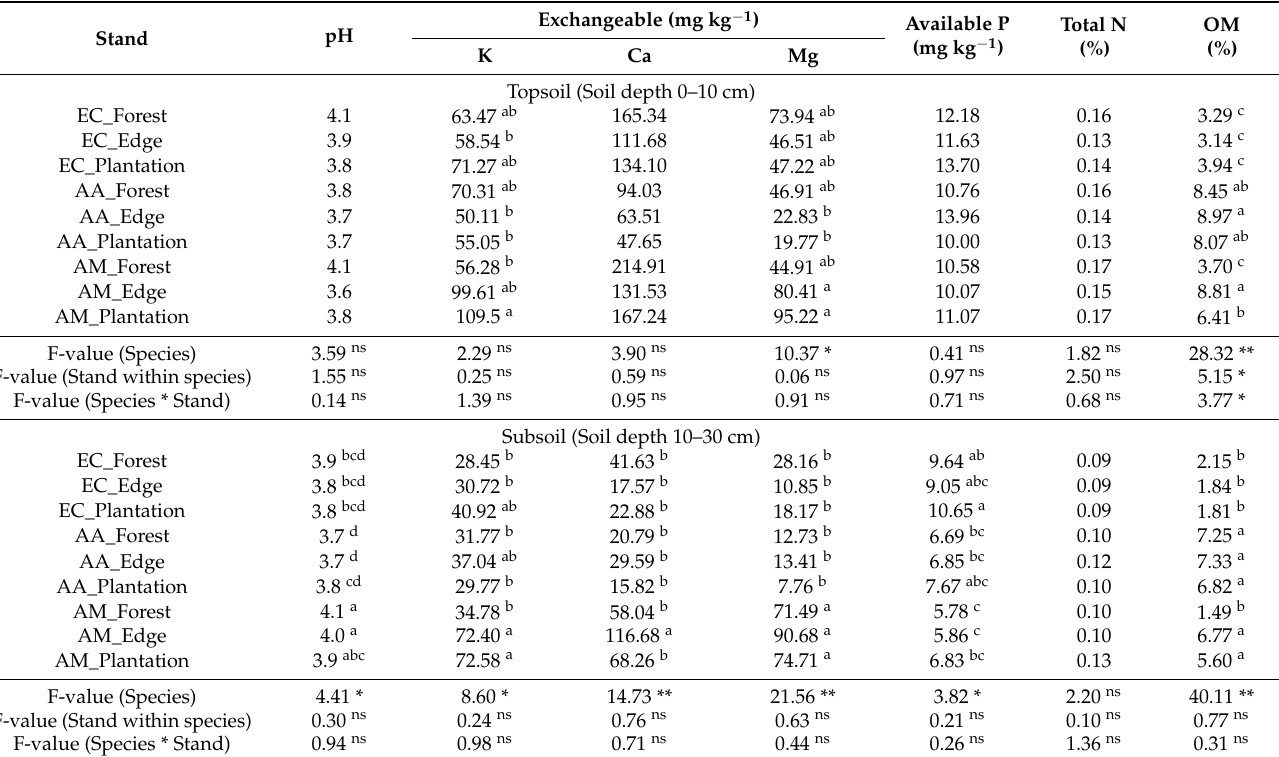
Table 3. Soil chemical properties in nine stands along the forest remnants to plantation stands of three exotic plantations. EC: Eucalyptus camaldulensis , AA: Acacia auriculiformis , AM: A. mangium . Significant differences: ns p ≥ 0.05; * p < 0.05, ** p < 0.01. Different superscript letters in the same column indicate significant difference at p <